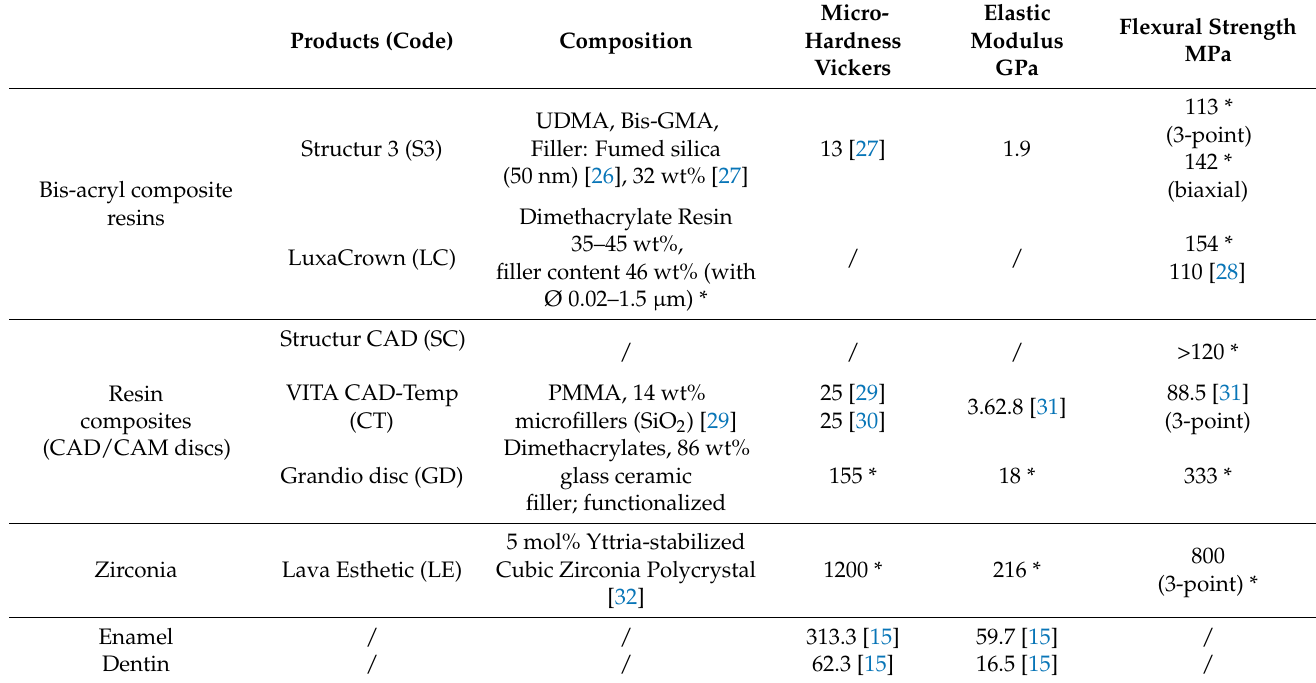
Table 1. Mechanical properties of tested materials with authorized type of restoration compared to enamel and dentine (* manufacturer’s